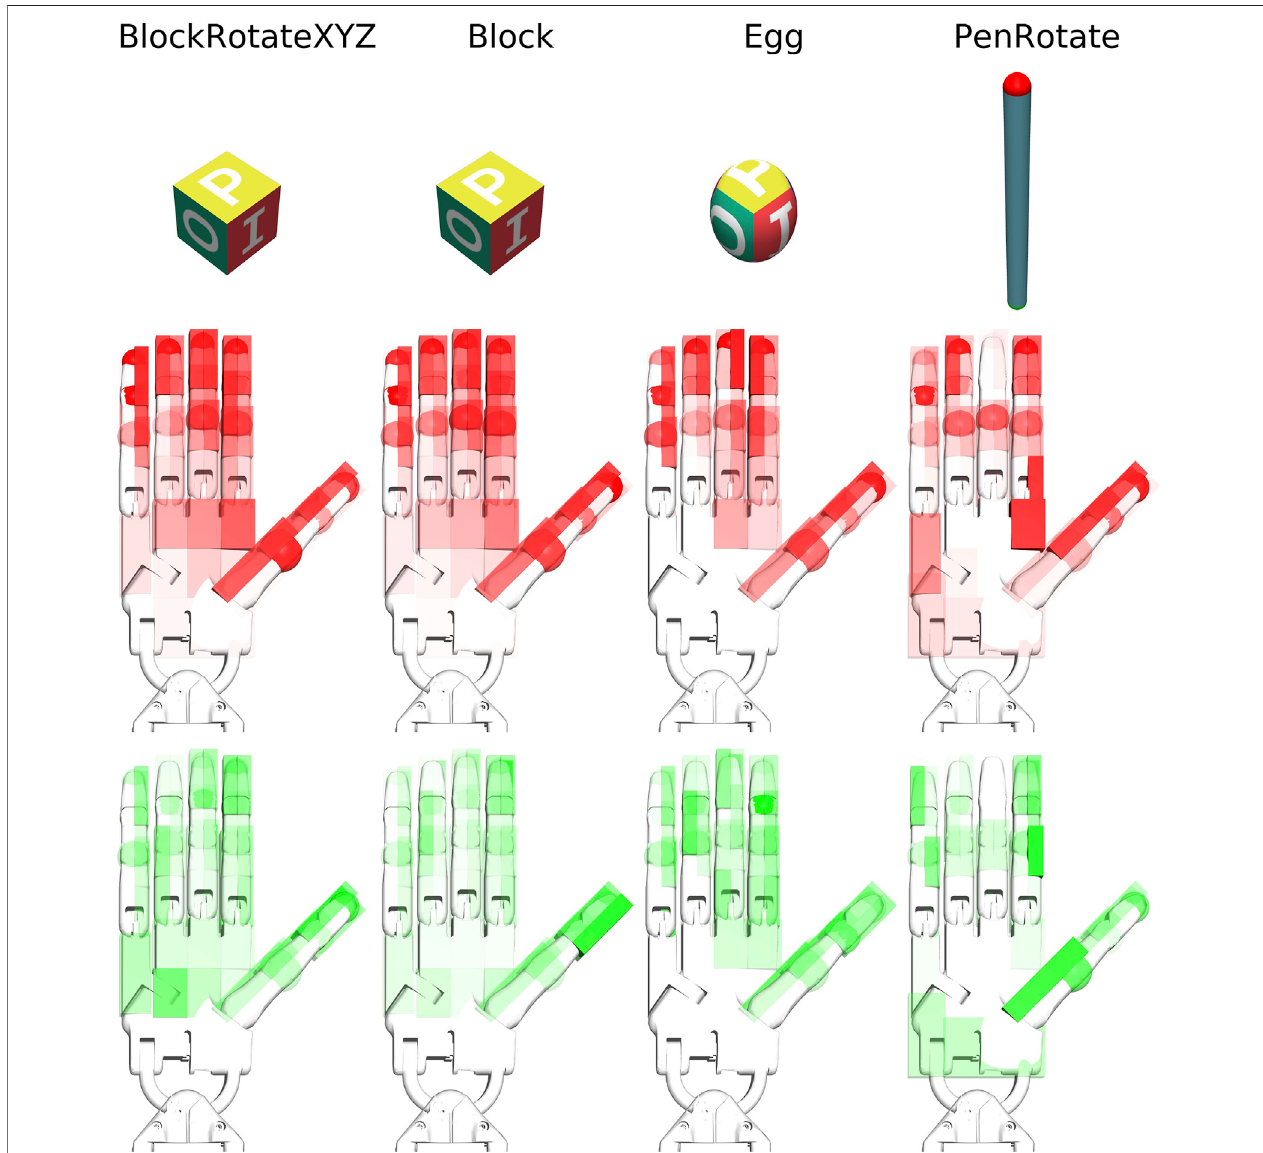
FIGURE 7 | Visualisation of sensors activation (red) and Q-difference (green) values from Table 8 . Values are normalized for each hand image.